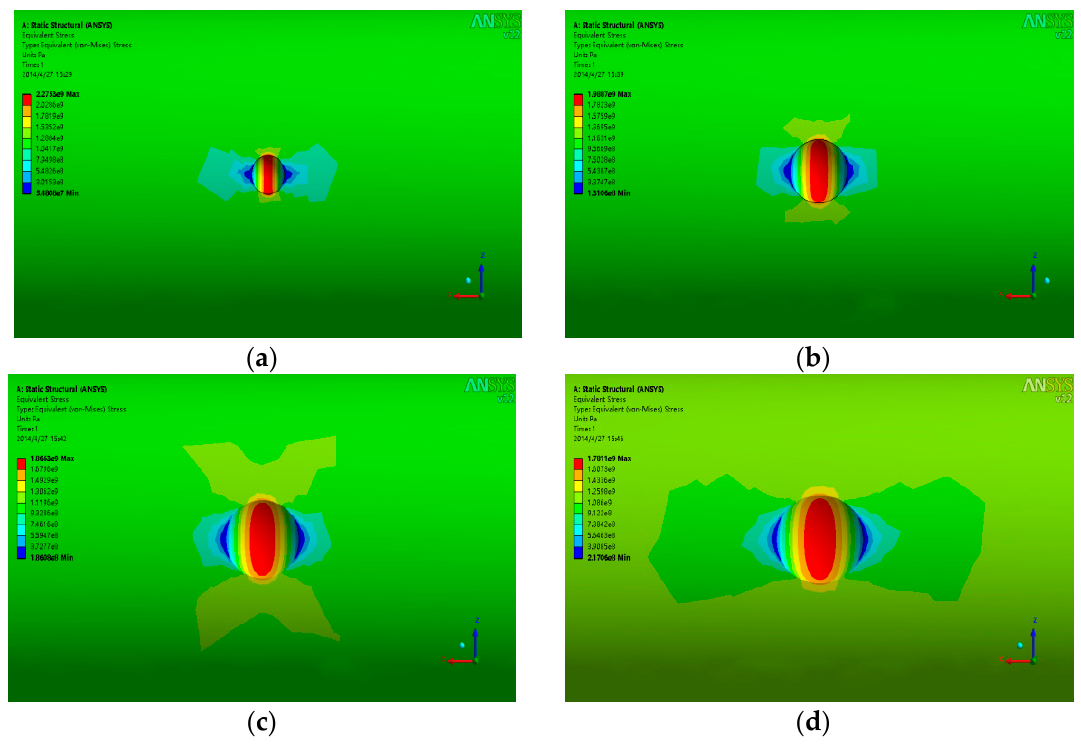
Figure 16. Three-dimensional simulation results of pit stress. ( a ) w/d = 2; ( b ) w/d = 3.3; ( c ) L/w = 1; ( d ) L/w = 1.5.